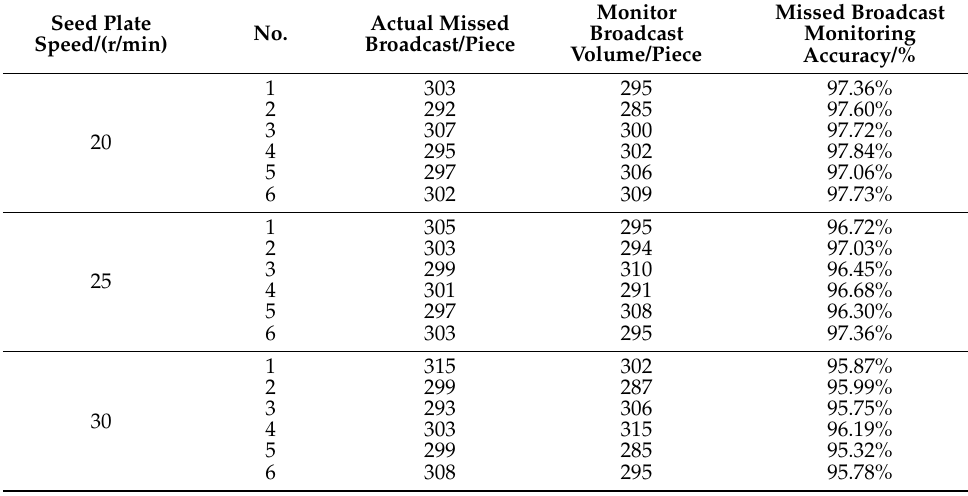
Figure 8. The sowing rate monitoring curve of the seed meter at different speeds. Table 2. Missed broadcast monitoring results of the seed meter at different speeds.